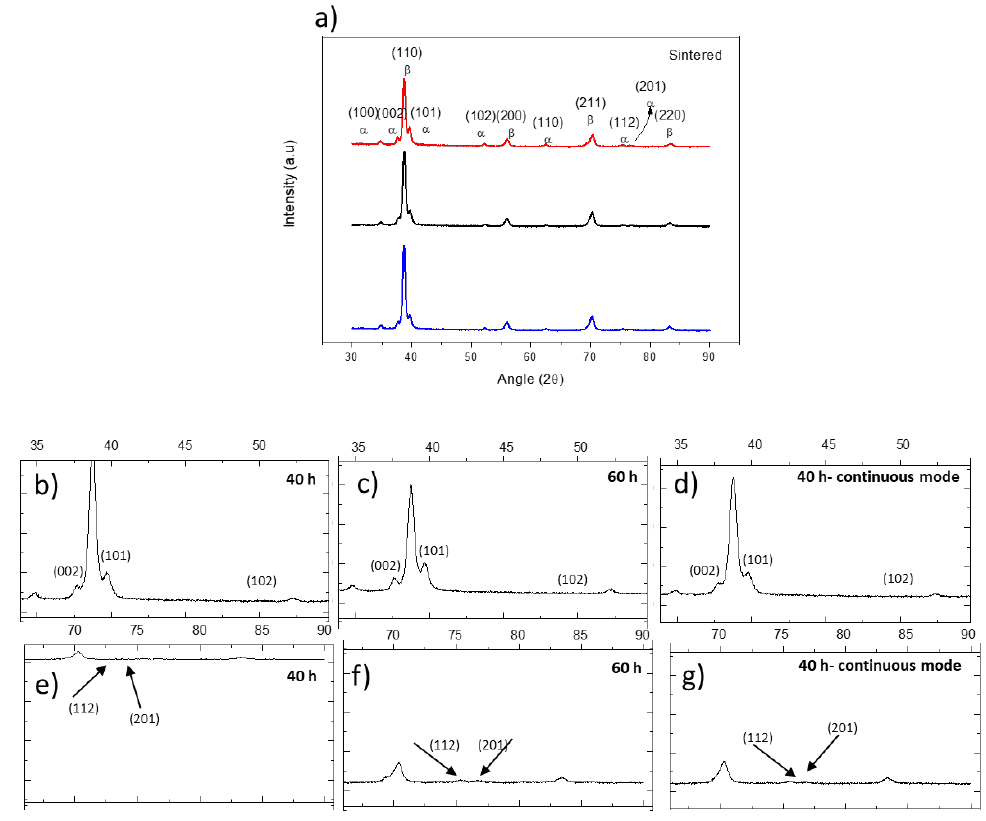
Figure 7. The XRD profile of the Ti-34Nb-6Mo sintered and obtained after 40 h and 60 h and 40 h in the continuous mode. ( a ) XRD profile of the Ti-34Nb-6Mo sintered and obtained after 40 h (in red), 60 h (in black) and 40 h in continuous mode (in blue). ( b – d ) are indicated in more details the main reflections peak between 2 Ɵ = 35 – 50° of samples sintered after 40 h, 60 h and 40 h in continuous mode. ( e – g ) are indicated in more details the main reflections peak between 2 Ɵ = 70 – 90° of samples sintered after 40 h, 60 h and 40 h in continuous mode. Table 5. Quality parameters of Rietveld refinement and the α and β phases %. Times R wp (%) R exp (%) α -Ti (%) β -Ti (%) 40 Sintered